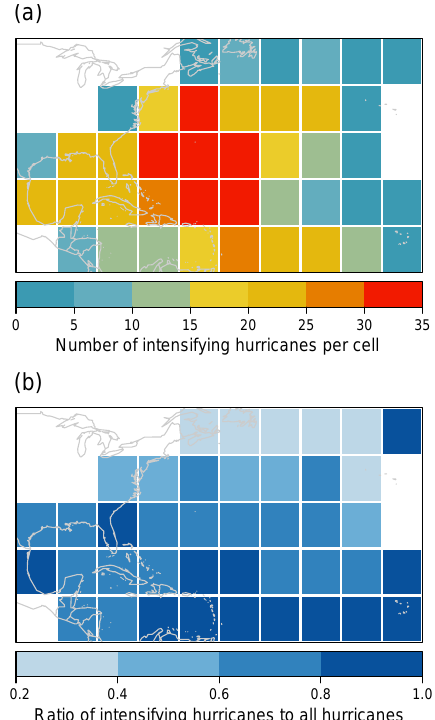
Figure 2. Hurricane intensification count and ratio per cell. (a) Number of intensifying hurricanes per cell, and (b) ratio of to- tal number of hurricanes with at least 1h of intensification to total number of hurricanes per cell. The data are from the period 1975– 2014.